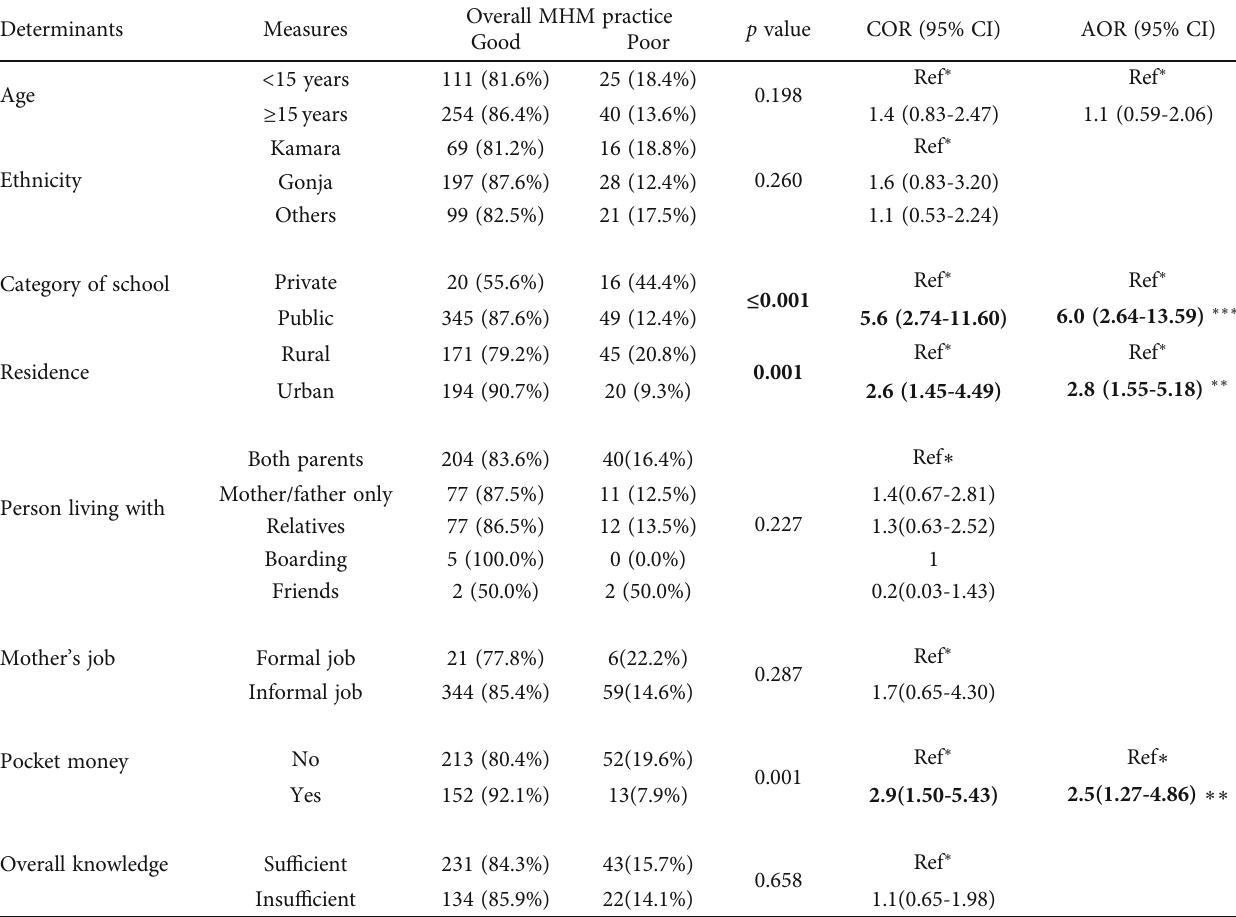
Table 3: Determinants of menstrual hygiene management practices among schoolgirls in West Gonja Municipality. Determinants